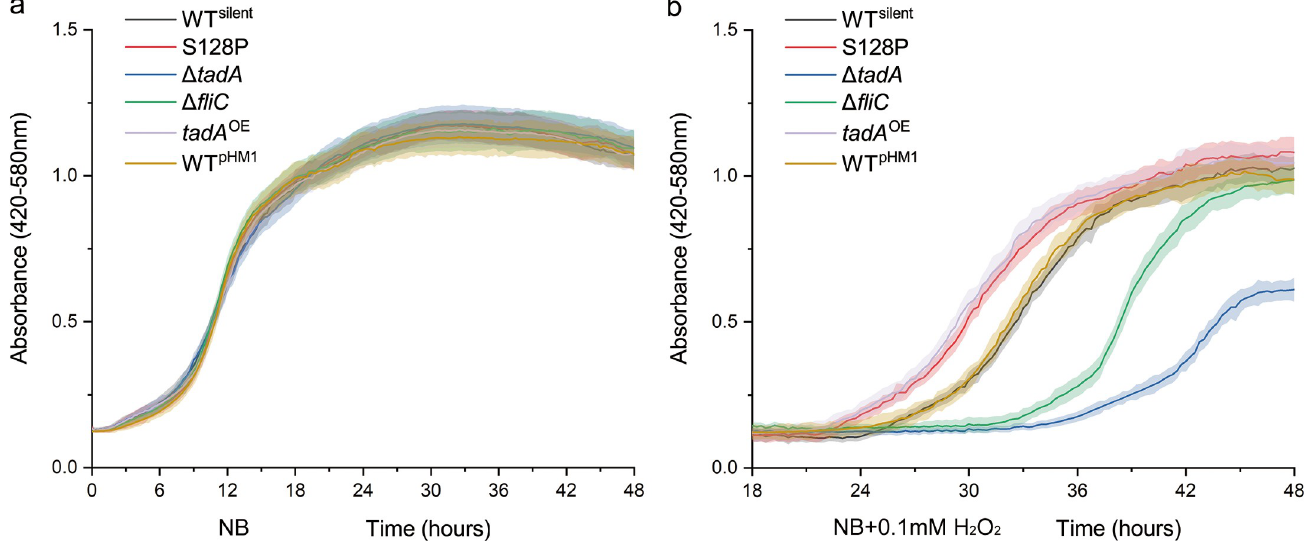
Fig 2. Growth of Xoc WT silent , S128P, Δ tadA , Δ fliC , tadA OE and WT pHM1 in NB medium. Strains were grown in quadruplicate to mid-exponential phase, diluted to OD 600 = 0.1, transferred to fresh NB and placed in a Bioscreen C apparatus at 28˚C. Panels: (a) growth in NB; (b) growth in NB supplemented with 0.1 mM H 2 O 2 . Error intervals (shaded regions) indicate mean ± SE of n = 4